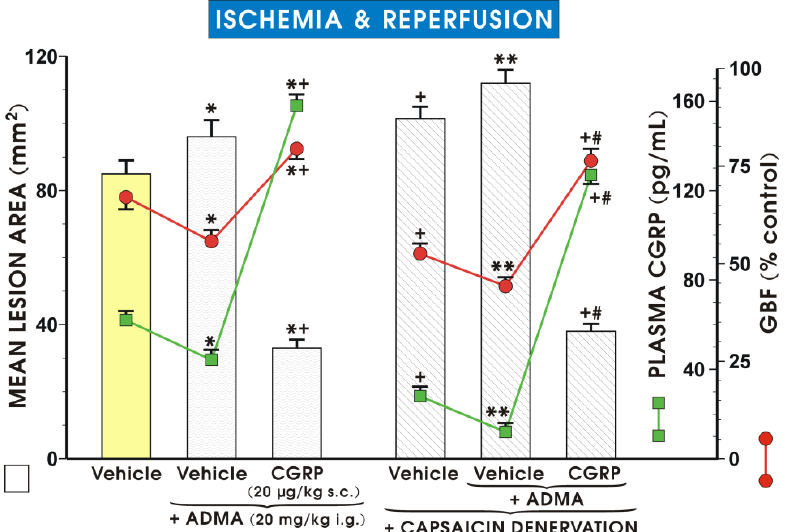
Figure 4. Mean lesion area of ischemia/reperfusion-induced damage, the alterations in the gastric blood flow (GBF), and the plasma CGRP levels in rats pretreated with ADMA alone or ADMA given in combination with CGRP in rats with or without capsaicin-induced denervation. Results are mean ± S.E.M of six to eight rats per group. Significant change ( p < 0.05) as compared with the respective values in vehicle (saline)-control group is indicated by asterisk. A cross and asterisk indicate significant change ( p < 0.05) as compared with vehicle-control group and with rats treated with vehicle or ADMA alone (left panel). Significant difference ( p < 0.05) between the respective values in the vehicle (saline)-control group and the vehicle-control with capsaicin denervation, is indicated by a cross. A double asterisk denotes the significant change ( p < 0.05) as compared with the respective values in vehicle-controls treated with ADMA without capsaicin denervation. A cross and a hash indicate significant change ( p < 0.05) compared to the values obtained in capsaicin-denervated rats treated with ADMA without concurrent treatment with